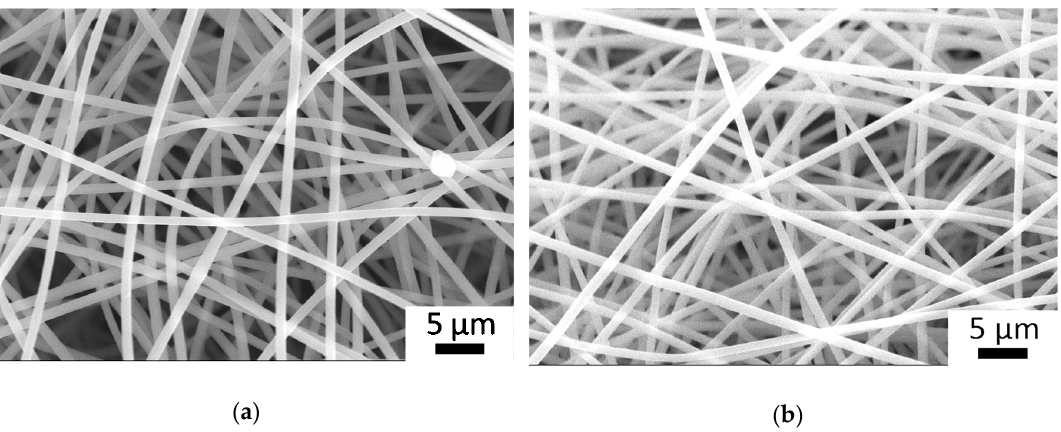
Figure 2. SEM image of electrospun allylamine-modified polysuccinimide fiber mat (PSI-AAm) ( a ) and the same after plasma treatment (PSI-AAmp) ( b ).